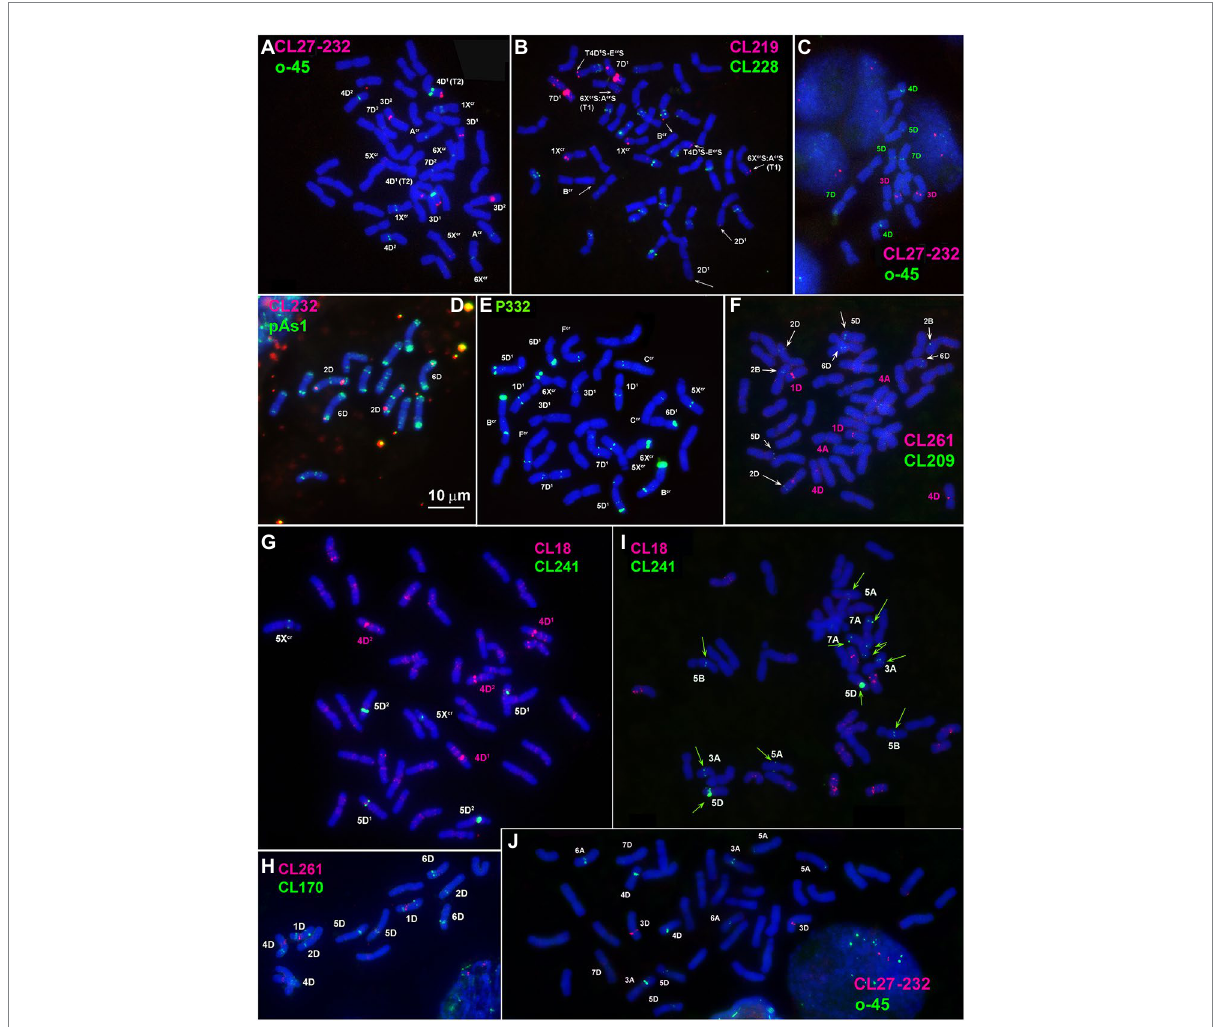
FIGURE 2 Localization of: (A,C,J) CL27_232 (red) + o45 (green), (B) CL219 (red) + CL228(green); (D) CL232 (red) + pAs1 (green); (E) P332 (green); (F) CL261 (red) + CL209 (green); (G,I) CL18 (red) + CL241 (green); (H) CL261 (red) + CL170 (green) on chromosomes of Ae . crassa , 4x (E) , 6x (A,B,F,G) , Ae . tauschii (C,D,H) and common wheat (I,J)